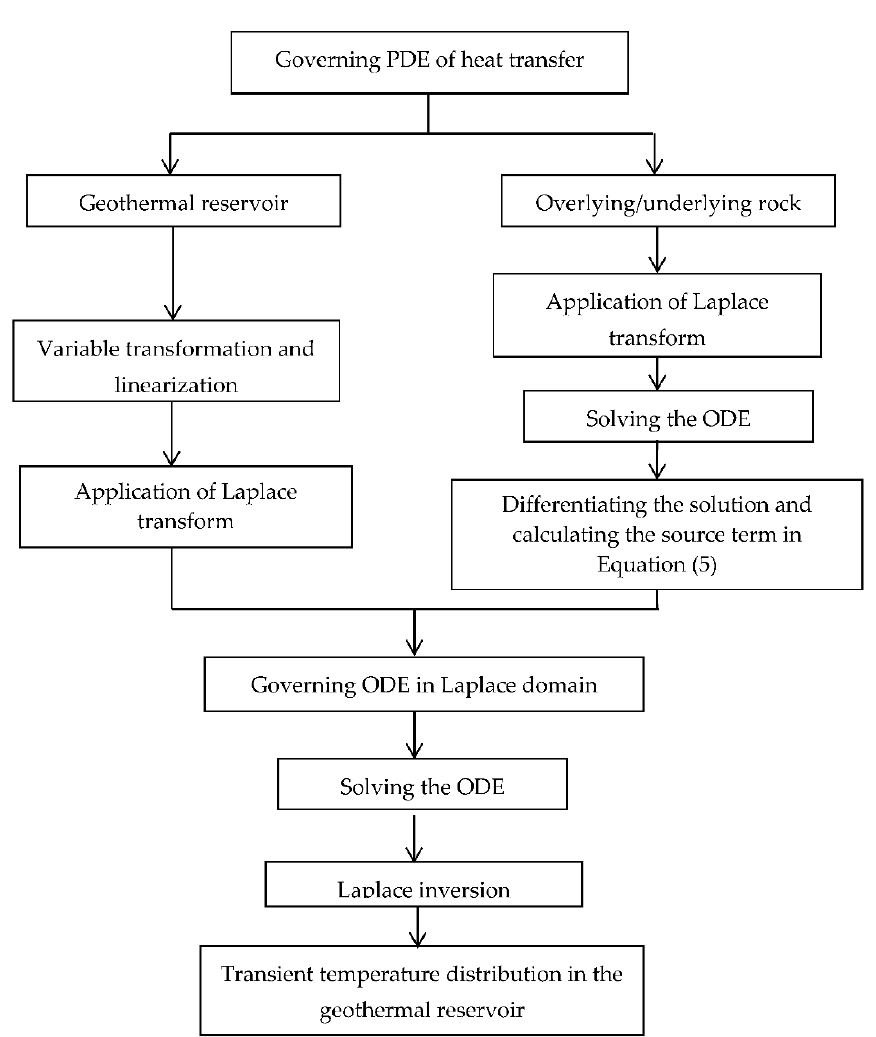
Figure 2. Flow chart showing the analytical solution procedure of the governing partial differential equations (PDEs). ODE is ordinary differential equation.